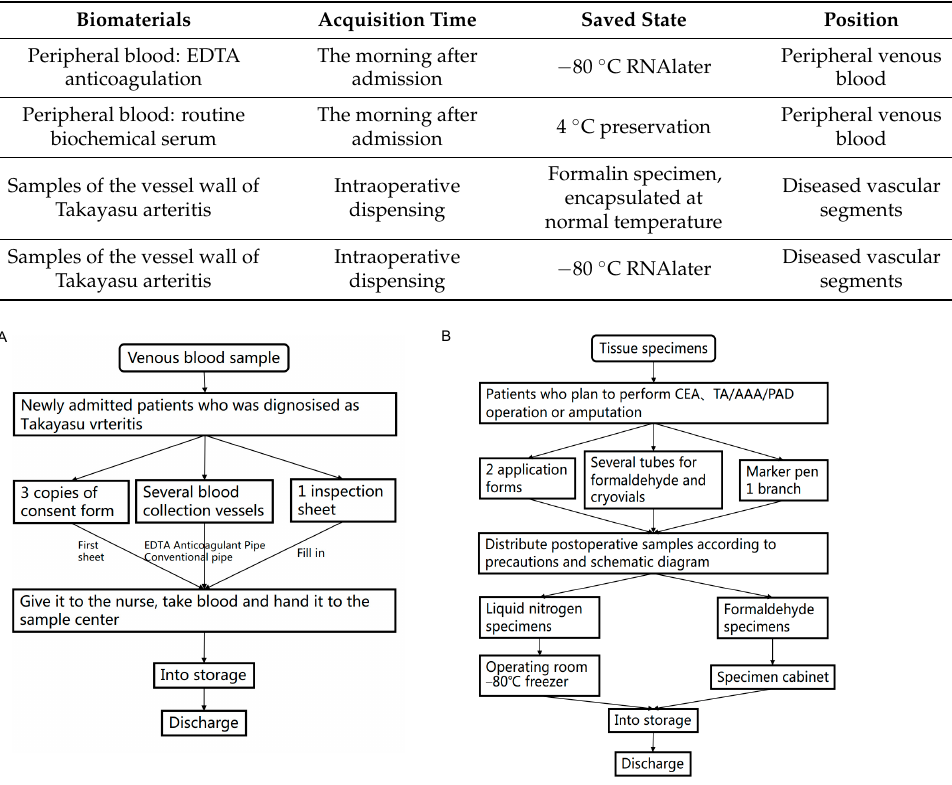
Table 2. Biological sample collection.